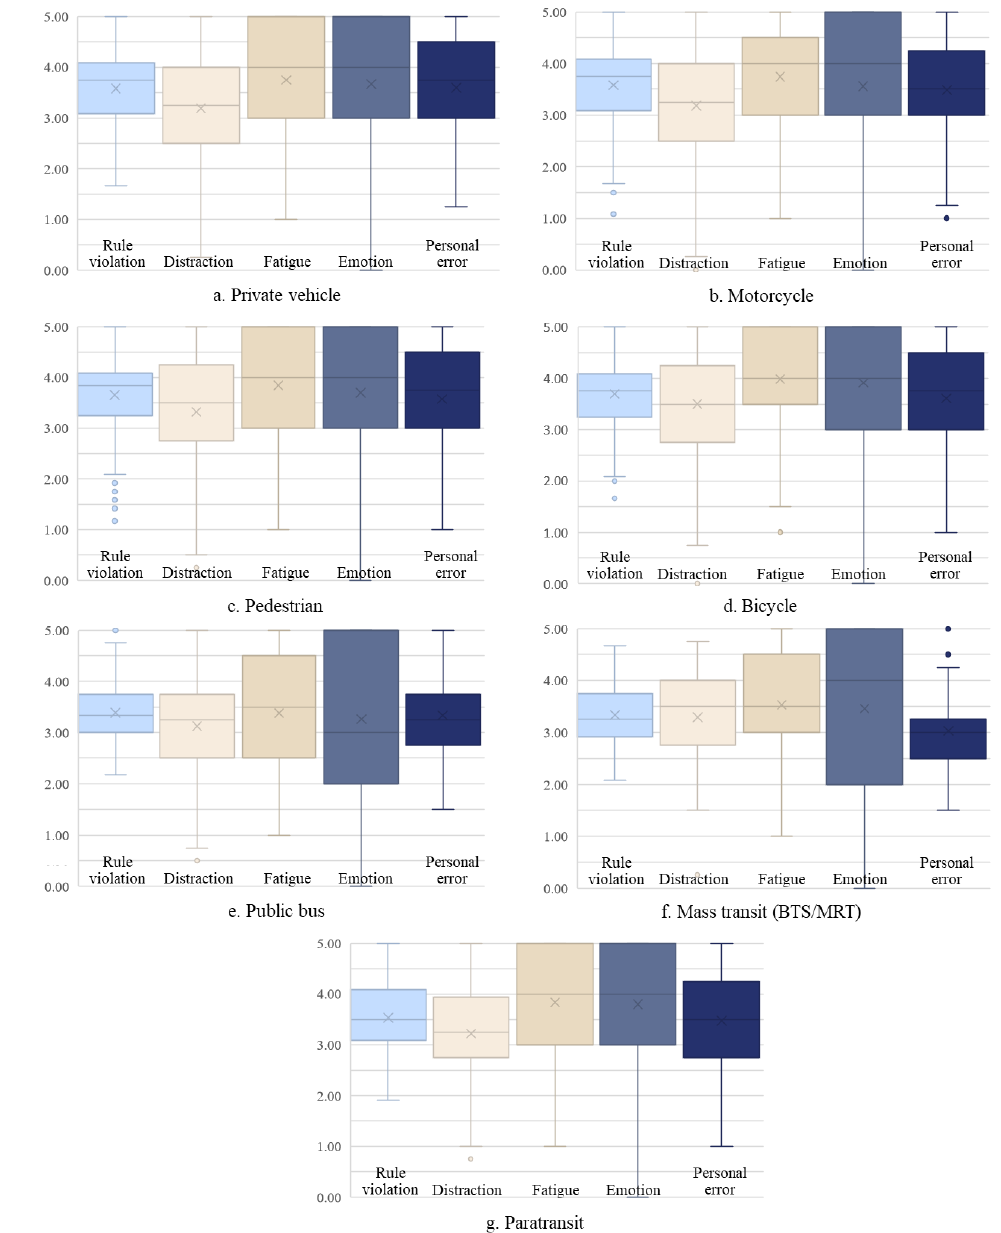
Figure 3. Perception of risk behaviors in different travel modes.